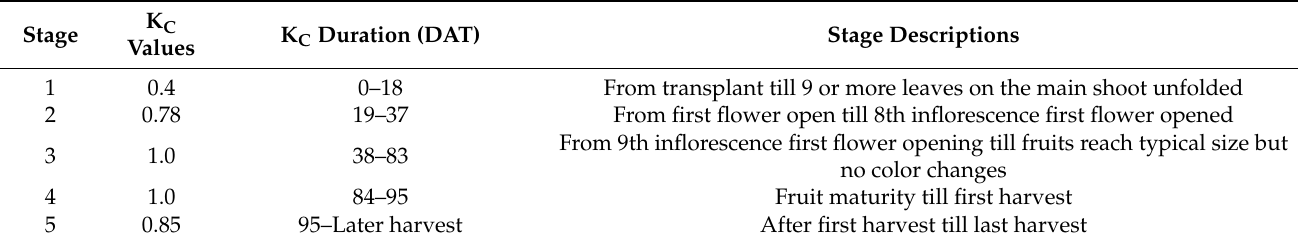
Table 3. Description of the tomato developmental stages and Kc values used as the guide for sampling collection. K C Stage